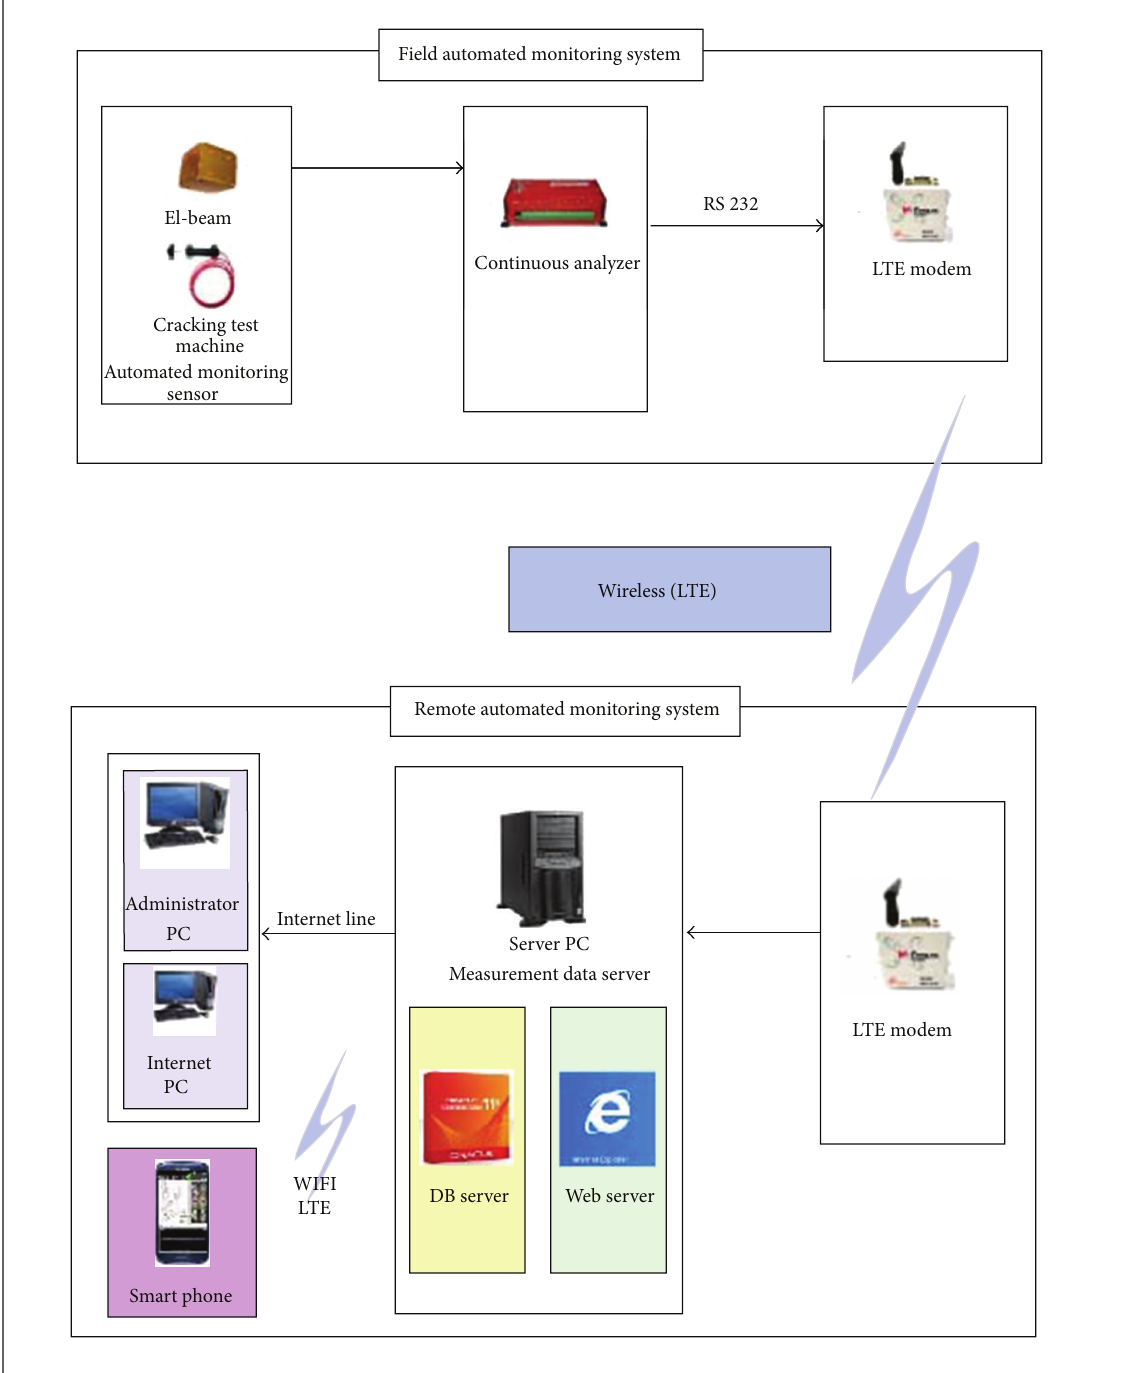
Figure 3: The diagram of applied monitoring system